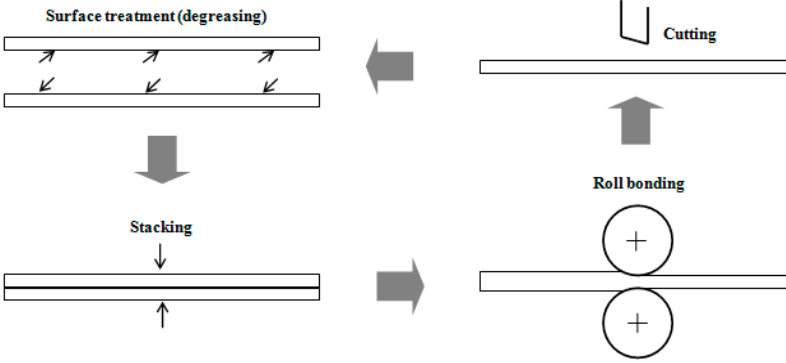
Figure 1. Diagrammatic illustration of the accumulative roll-bonding (ARB) process.